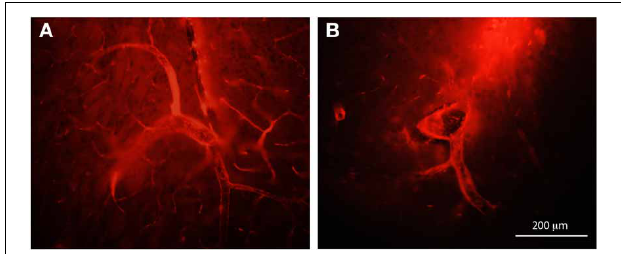
FIGURE 9 | Paravascular distribution of biotin dextrans, following intraventricular injection. Coronal sections of adult brains following intraventricular injection of BDA70K (A) or BDA10K (B). Note that most of the tracer is present in the paravascular or Virchow-Robin space and not in the lumen of blood vessels. Scale bar 200 μ